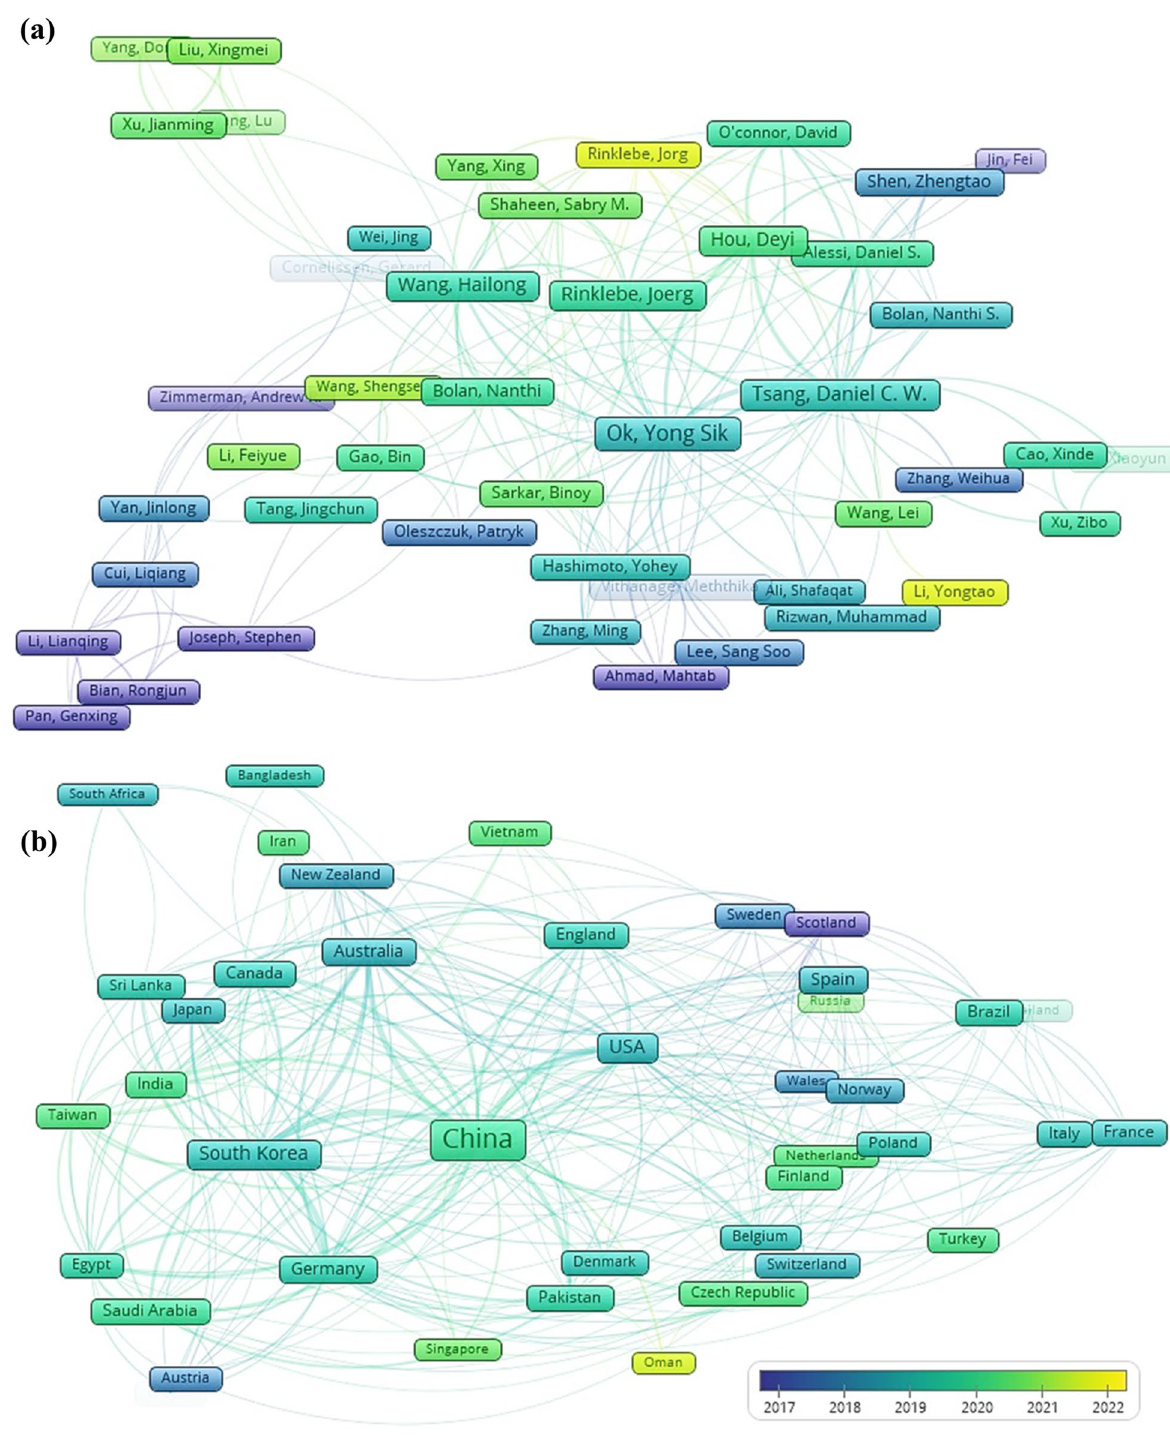
Fig. 6 Bibliometric network for remediation of contaminated soil between a authors and b countries for minimum 5 document